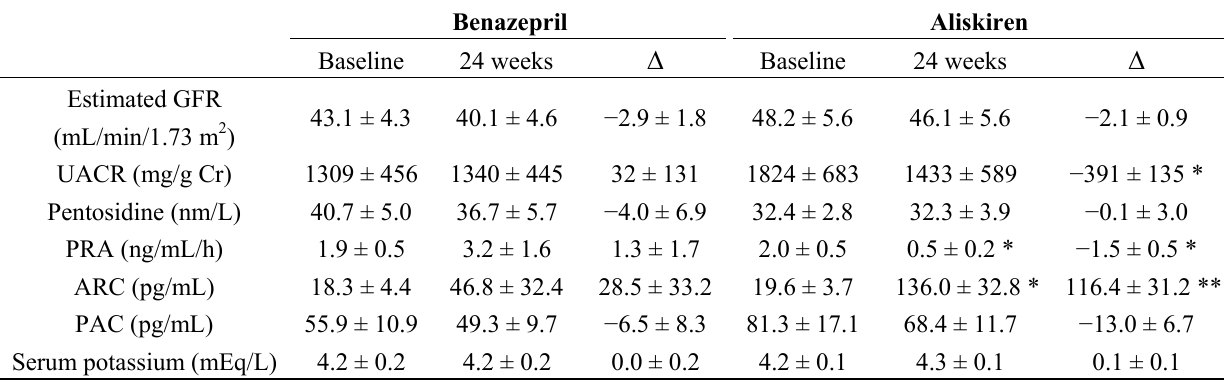
Table 5. Comparison of the effects of add-on anti-hypertensive treatments on parameters of renal function, oxidative stress and RAS components.